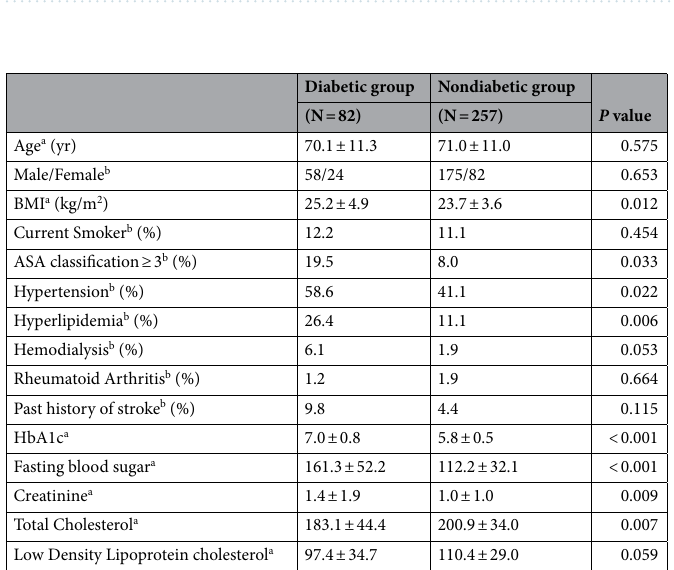
(Table 1). The diabetic group had a higher BMI (25.2 vs. 23.7 kg/m 2 , P = 0.012) and included a higher percentage of patient with an ASA classification of ≥ 3 (19.5% vs. 8.0%, P < 0.001), hypertension (58.6% vs. 41.1%, P = 0.022), and hyperlipidemia (26.4% vs. 11.1%, P = 0.006) than the nondiabetic group. No significant intergroup differences were observed with respect to hemodialysis, rheumatoid arthritis, and past history of stroke. The diabetic group